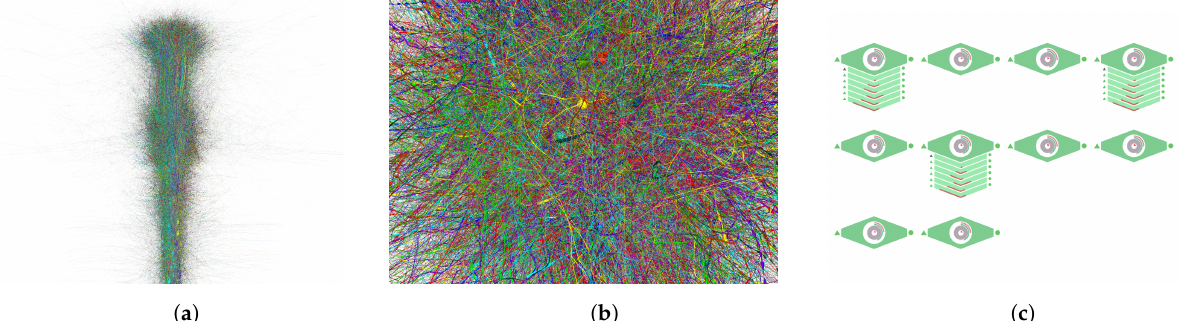
Figure 6. Microcolumns in a column. ( a ) Realistic representation: far view; ( b ) realistic representation: closeup view; ( c ) abstract